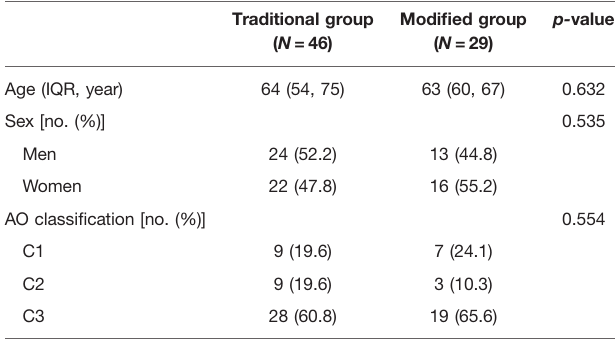
TABLE 1 | Demographic and clinical characteristics of patients of patellar fracture.